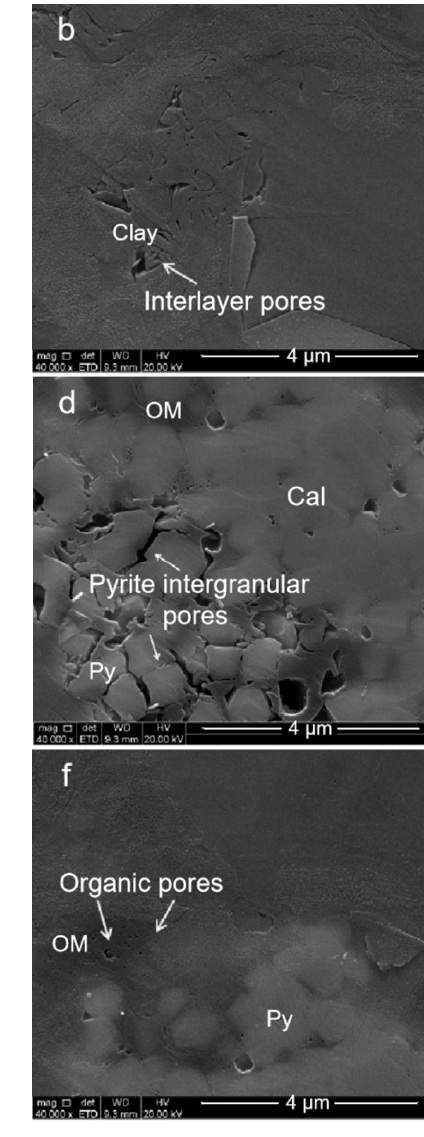
Figure 2. Original sample (Ro = 0.5%), where only a few micropores are developed: ( a ) intergranular pores; ( b ) clay interlayer pores; ( c ) microcracks; ( d ) pyrite intergranular pores; ( e ) organic pores; and ( f ) organic pores.